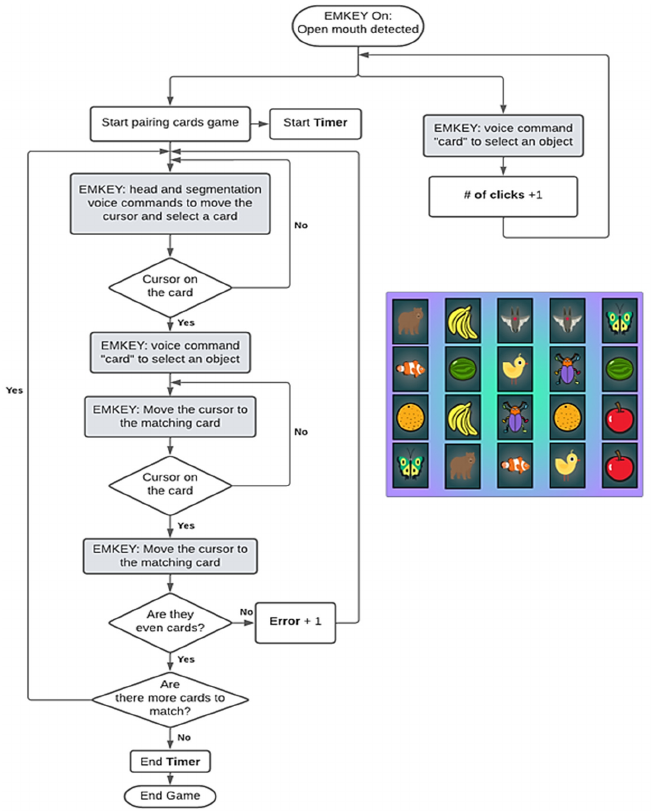
Figure 3. Pairing cards game flowchart and random array of figures to match.